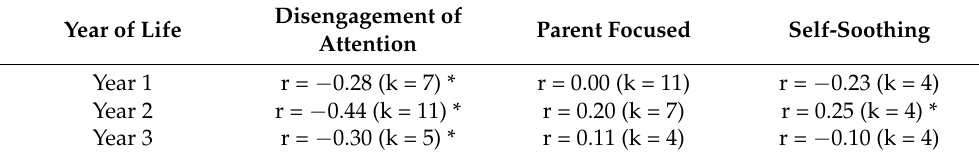
Table 2. Summary of